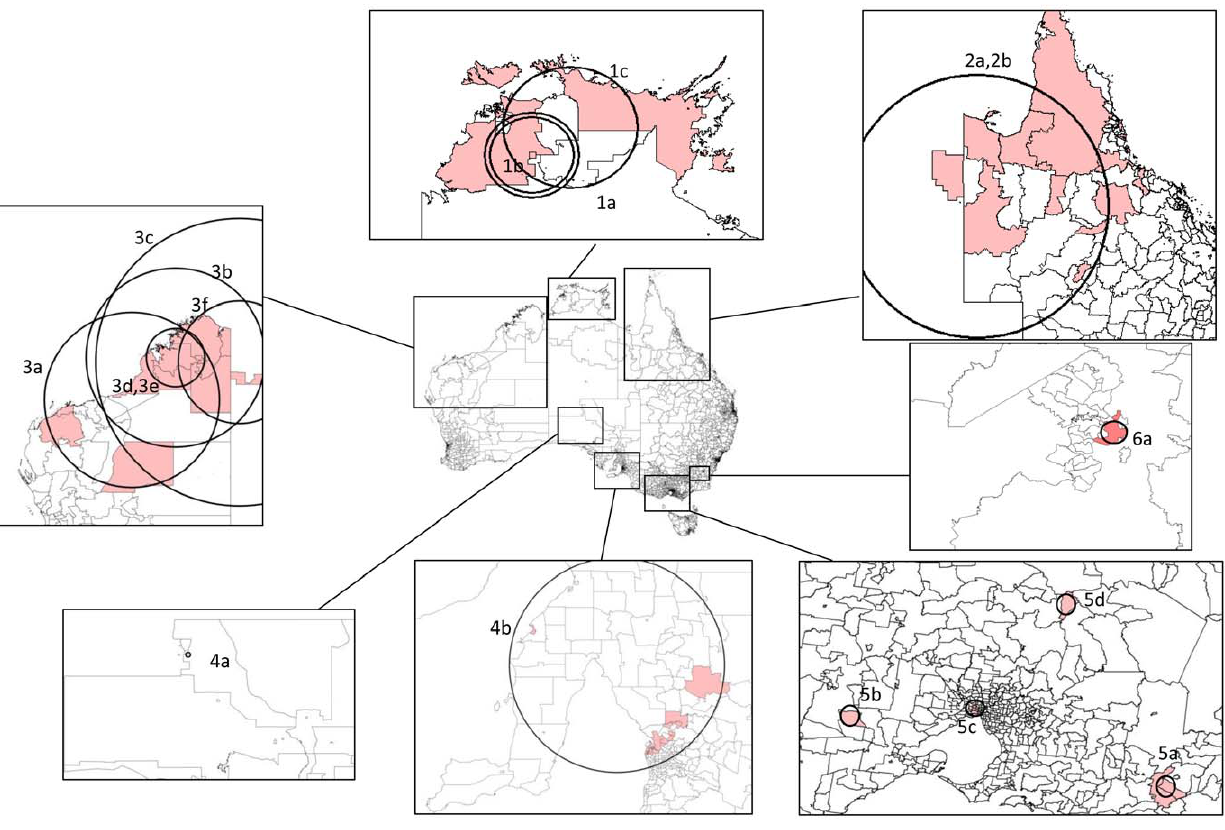
Figure 4. Significant clusters identified by state cluster detection. doi:10.1371/journal.pone.0054168.g004 Table 3. Significant clusters identified by state cluster